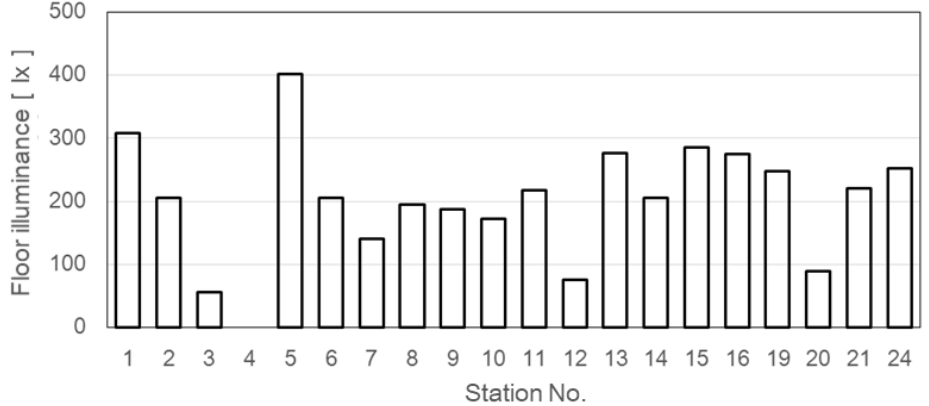
Figure 6. Floor illuminance measurement result at the exit of stairs.